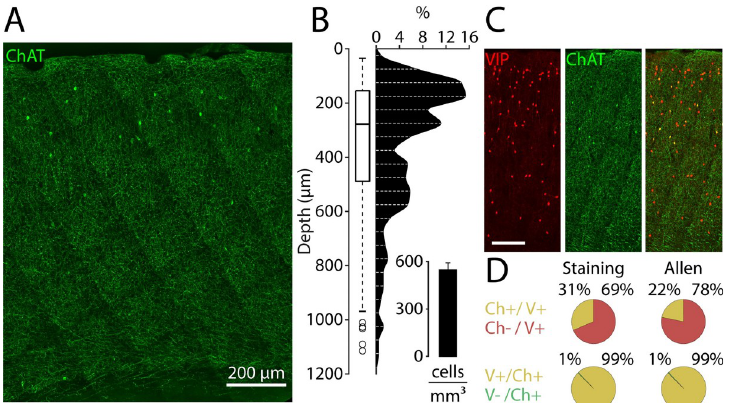
Fig 1. VChI cortical density and VIP/ChAT colocalization. (A) Cortex stained with ChAT primary antibody in a 30- μ m–thick coronal slice (maximum intensity z-projection; Alexa 647). (B) VChI distribution across cortical depth ( n = 261 cells; 3 mice). Inset: cell counts per cubic millimeter. (C) Cortex of a VIP-tdTomato mouse stained with ChAT (maximum intensity z-projection; Alexa 647). Left: tdTomato; Middle: ChAT; Right: overlay (scale: 100 μ m). (D) Respective ratios of cortical ChAT + and VIP + neuronal populations. Left: staining data. Right: Allen Institute single- cell RNA-seq data (“Ch” = ChAT; “V” = VIP). ChAT, choline acetyltransferase; RNA-seq, RNA sequencing; VChI, VIP/ChAT interneuron; VIP, vasoactive intestinal polypeptide.